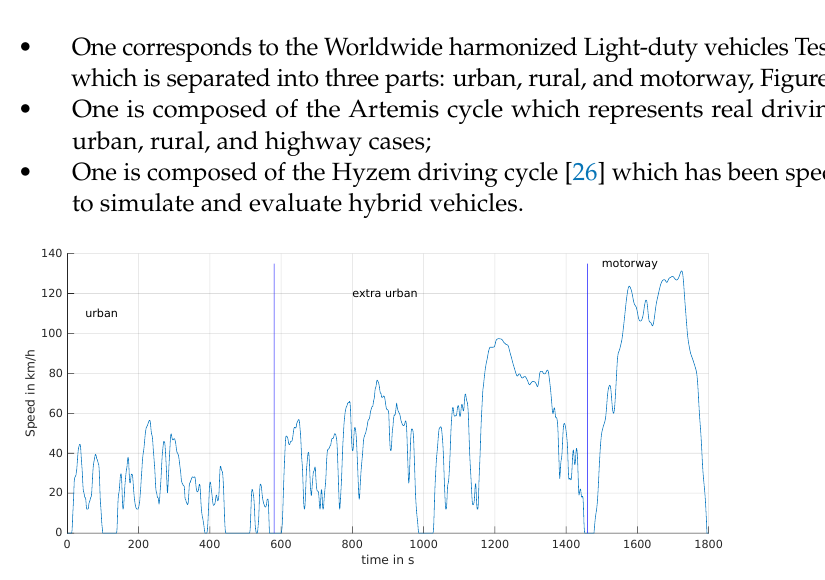
Figure 4. WLTC cycle and driving condition.